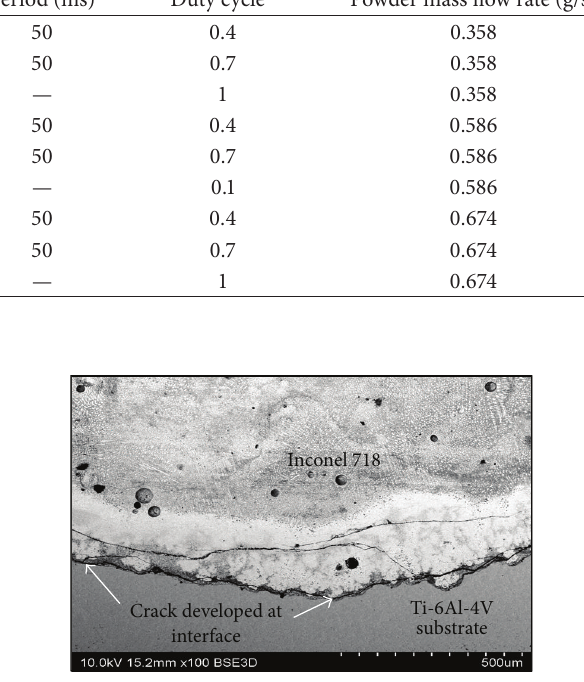
Figure 2: Cracked interface between Ti-6Al-4V and Inconel 718 in sample 4.